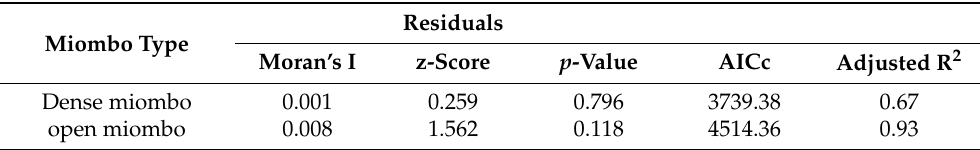
Figure 3. GWR local spatial distribution of standardized residuals for dense ( a ) and open ( b ) miombo woodland. Table 2. Residuals of the spatial autocorrelation and GWR fit statistics from the two types of miombo woodlands.